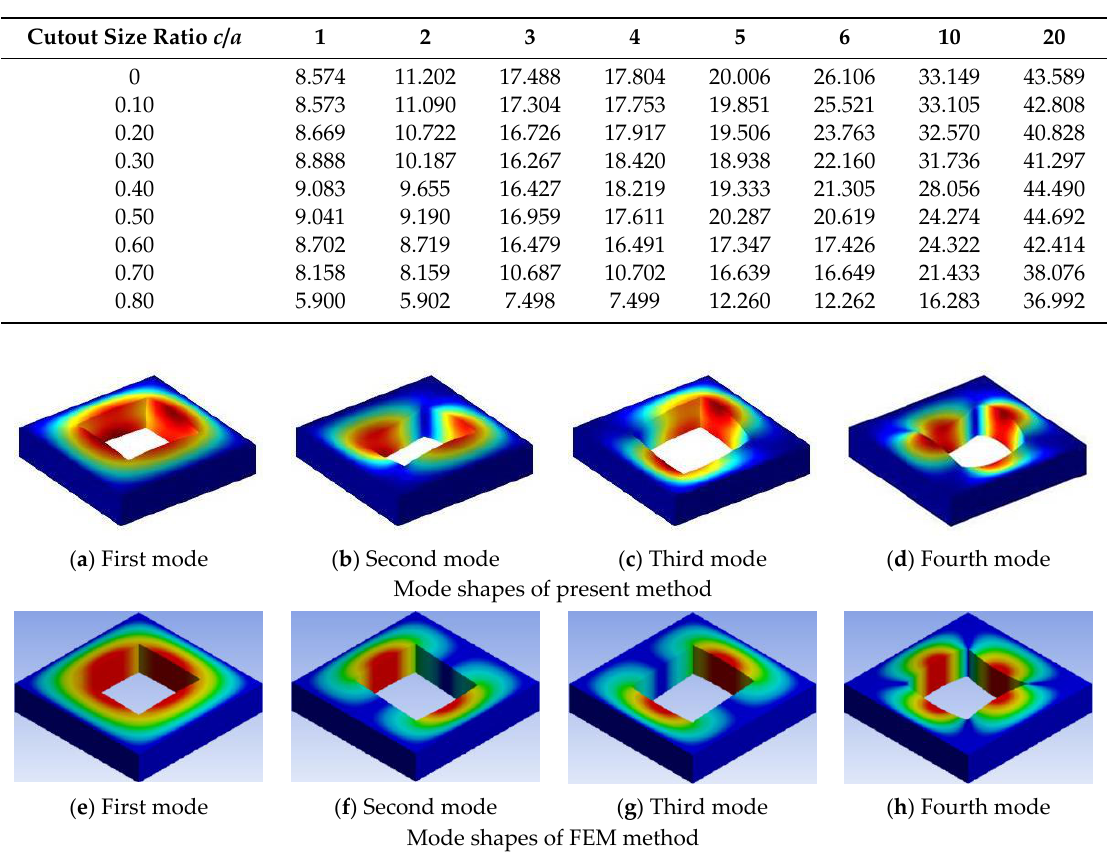
Figure 3. First four mode shapes of (0°/90°/0°/90°) laminated square plate with CCCC boundary condition for a cutout size ratio of 0.5. Table 8. Some of the first 20 frequency parameters Ω of cross-ply (0°/90°/90°/0°) laminated square plate with different cutout sizes under CSCS boundary condition